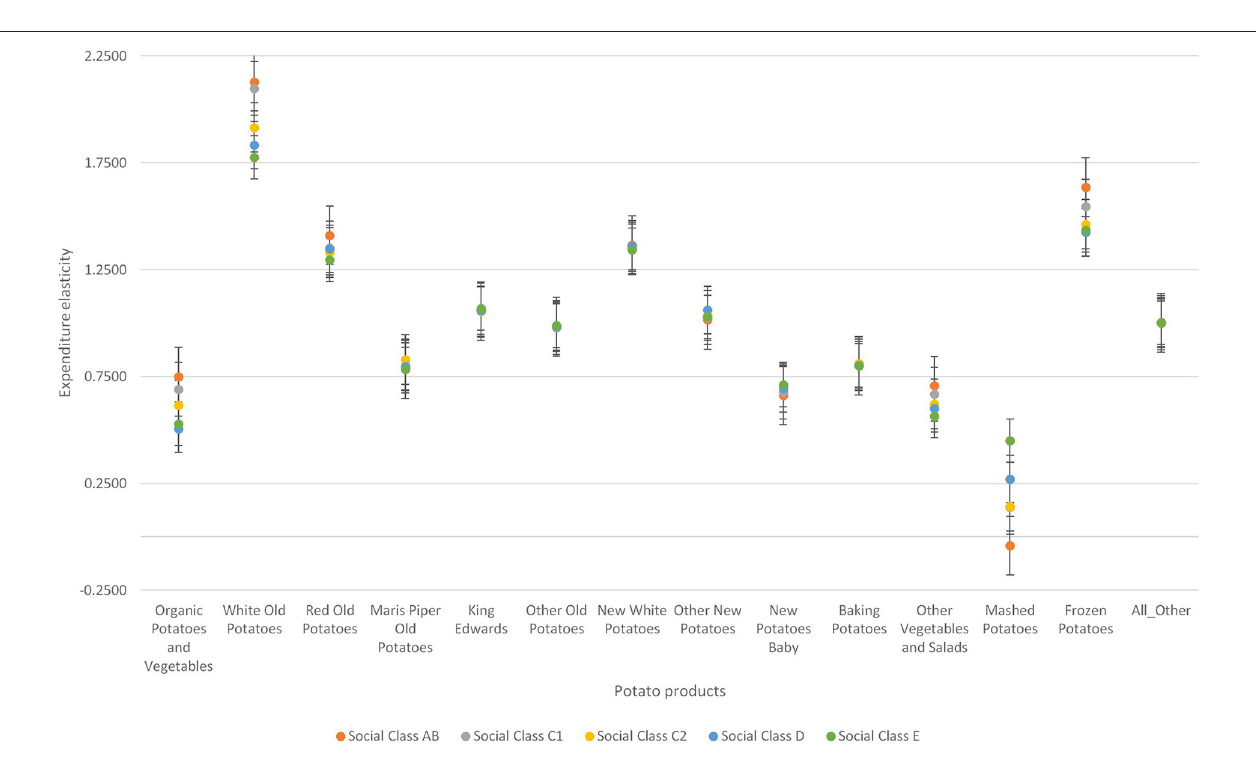
Frontiers in Nutrition |